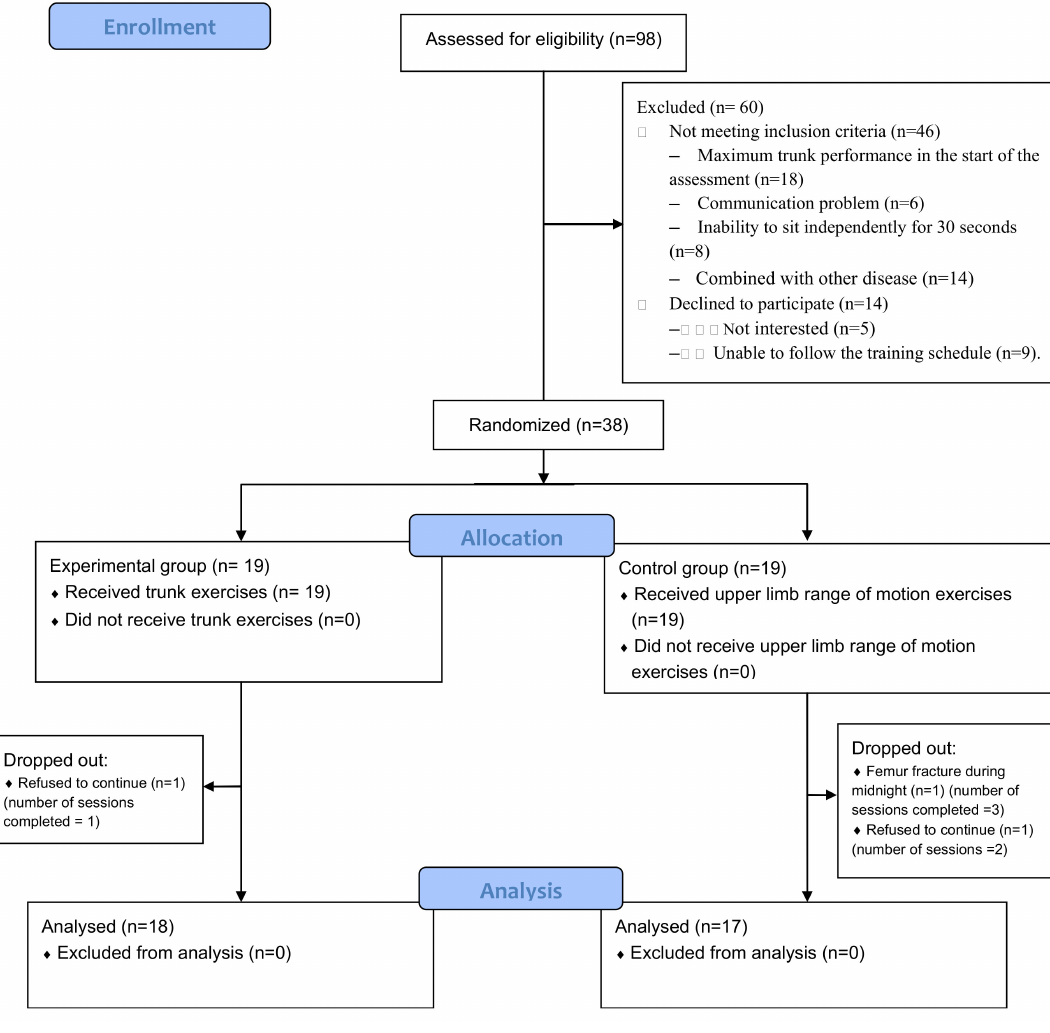
Figure 1. Flow chart of the